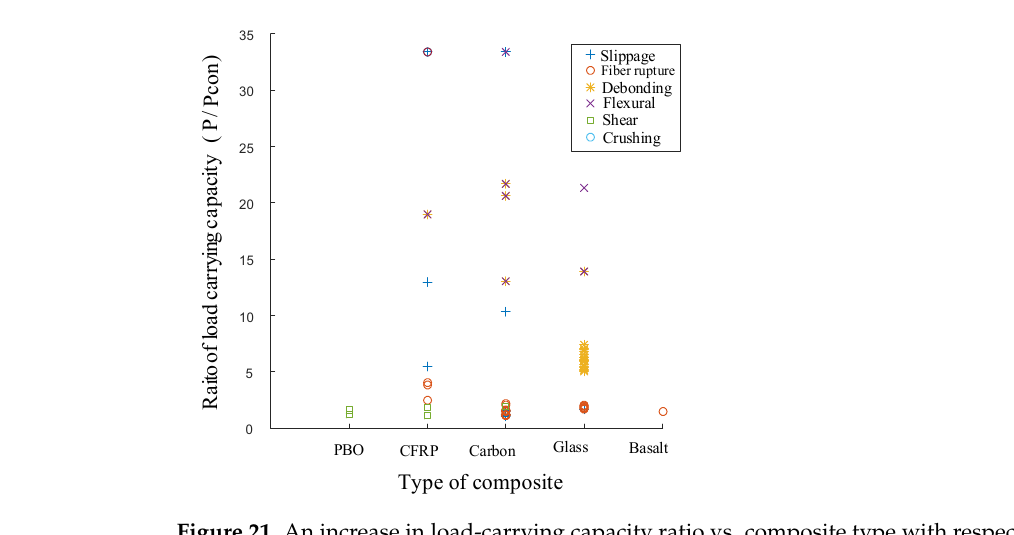
Figure 23. Force–deflection relation for strengthened and unstrengthened slab samples [110]. TRM also has a significant effect on controlling local damage to RC slabs under acci- dental or deliberate events. Strengthened RC slabs also decline the local damage in RC slabs from the front and back faces, specifically with the same impact velocity. The value of the ejected weight of the slabs in two faces also proves the effectiveness of TRM in strengthening slabs over bare ones (Figure 24). TRM reinforcement accordingly boosts the ballistic limit velocity by approximately 21% [111] . The effect of three various composites of FRCM, C-FRP, and silane modified graphene (SGr) as a method to strengthen one-way RC slabs indicated that such materials boosted the flexural strength of RC slabs around 1.3–2 times than unstrengthened ones. Additionally, the composite material affected the displacement ductility performance of the one-way slab system. The exposed FRCM slab also had a 13% increase in its displacement compared to the unexposed specimens [112]. The impact of TRM on various parameters, strengthening configurations, and different textile fibers of material groups (C vs. G) was investigated, and the initial cracking in the slab revealed that covering the full face in the slab was the most effective way to increase the flexural capacity than other ways. Additionally, in pre-cracked slabs, the effectiveness 0